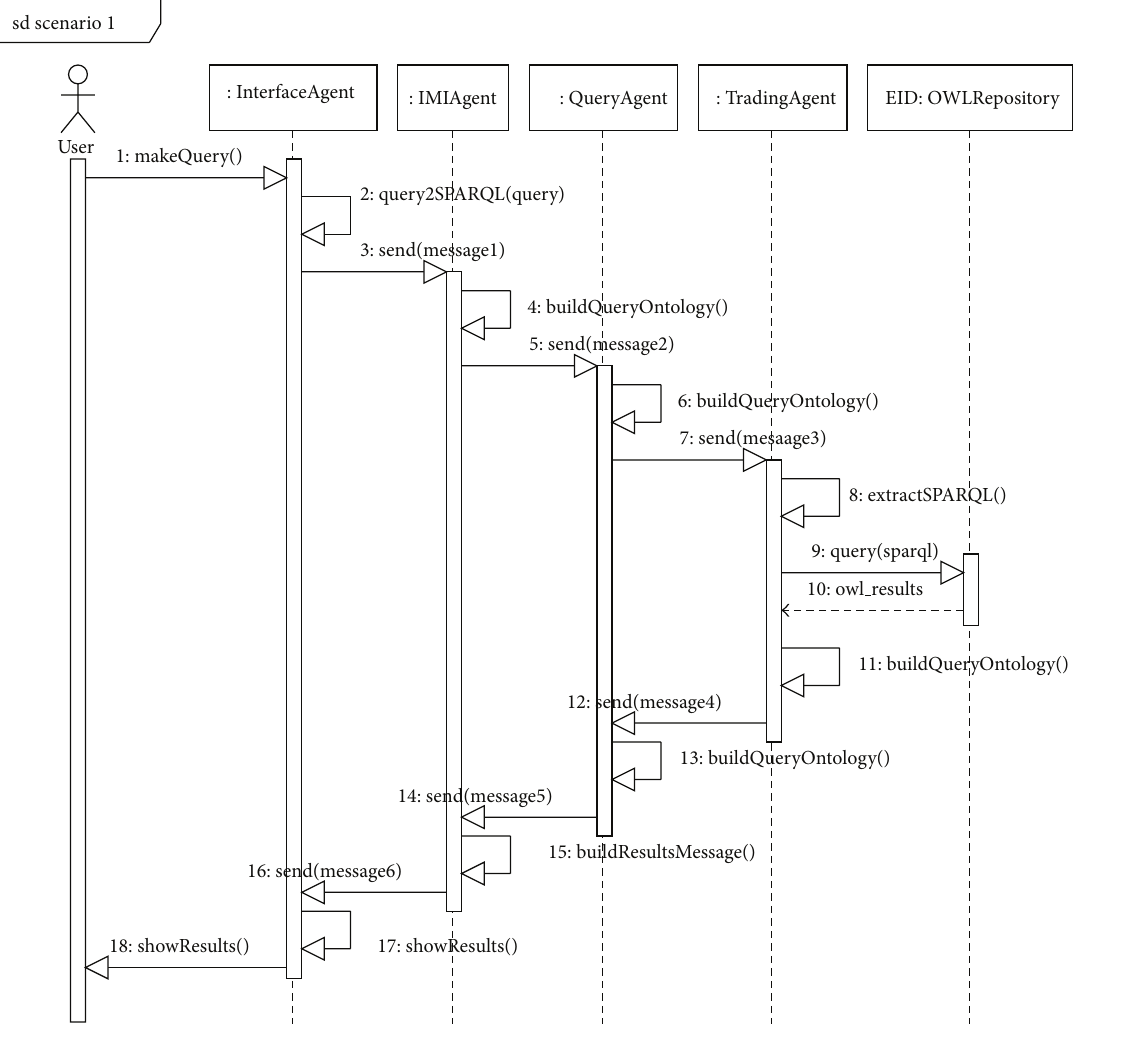
Figure 11: Sequence diagram for Scenario number 1